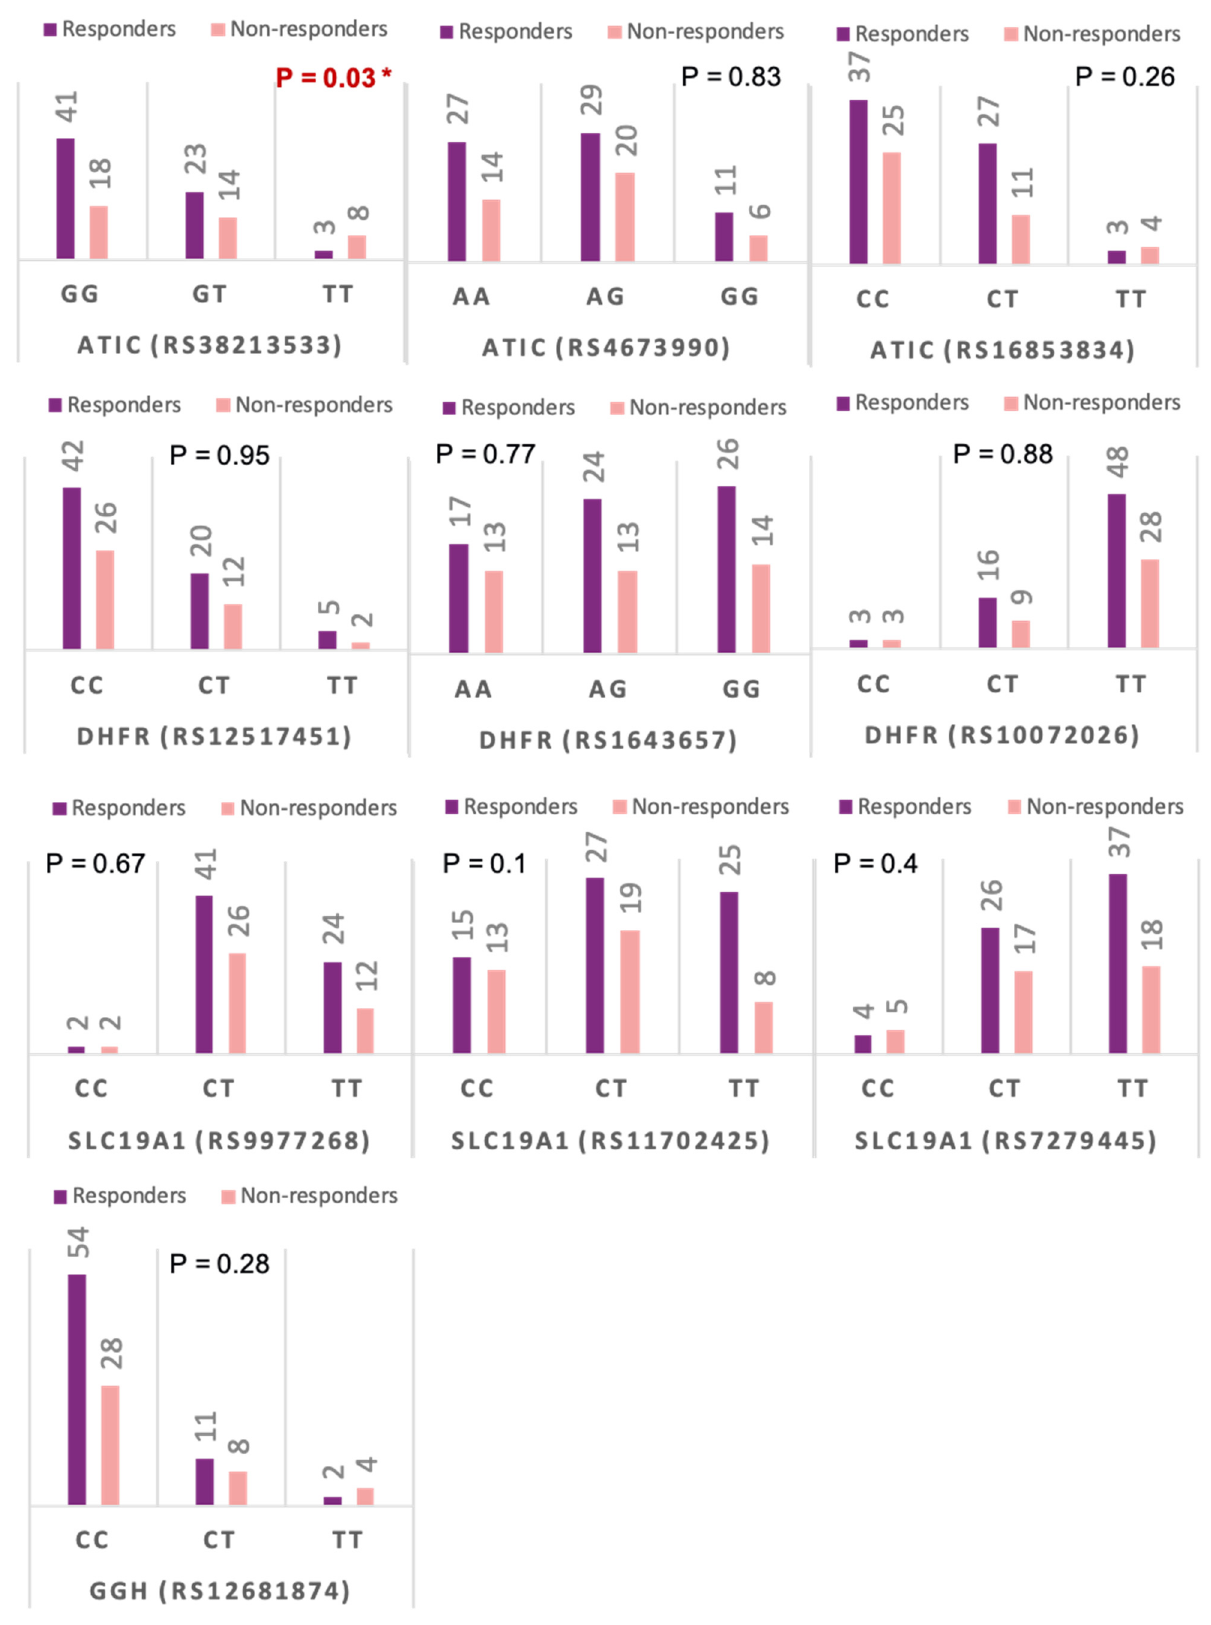
Figure 4. Genotype frequencies of the studied genetic variants in relation to methotrexate treatment response. * p -value < 0.05 and statistically significant.